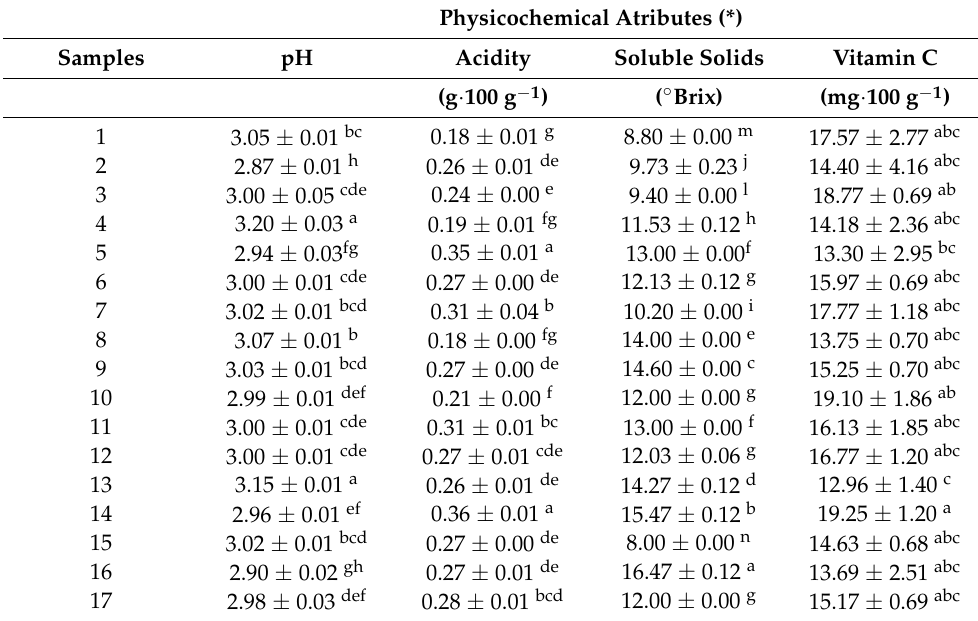
Table 2. Murici and tapereb á blend beverages physicochemical analysis results. Physicochemical Atributes (*) Samples